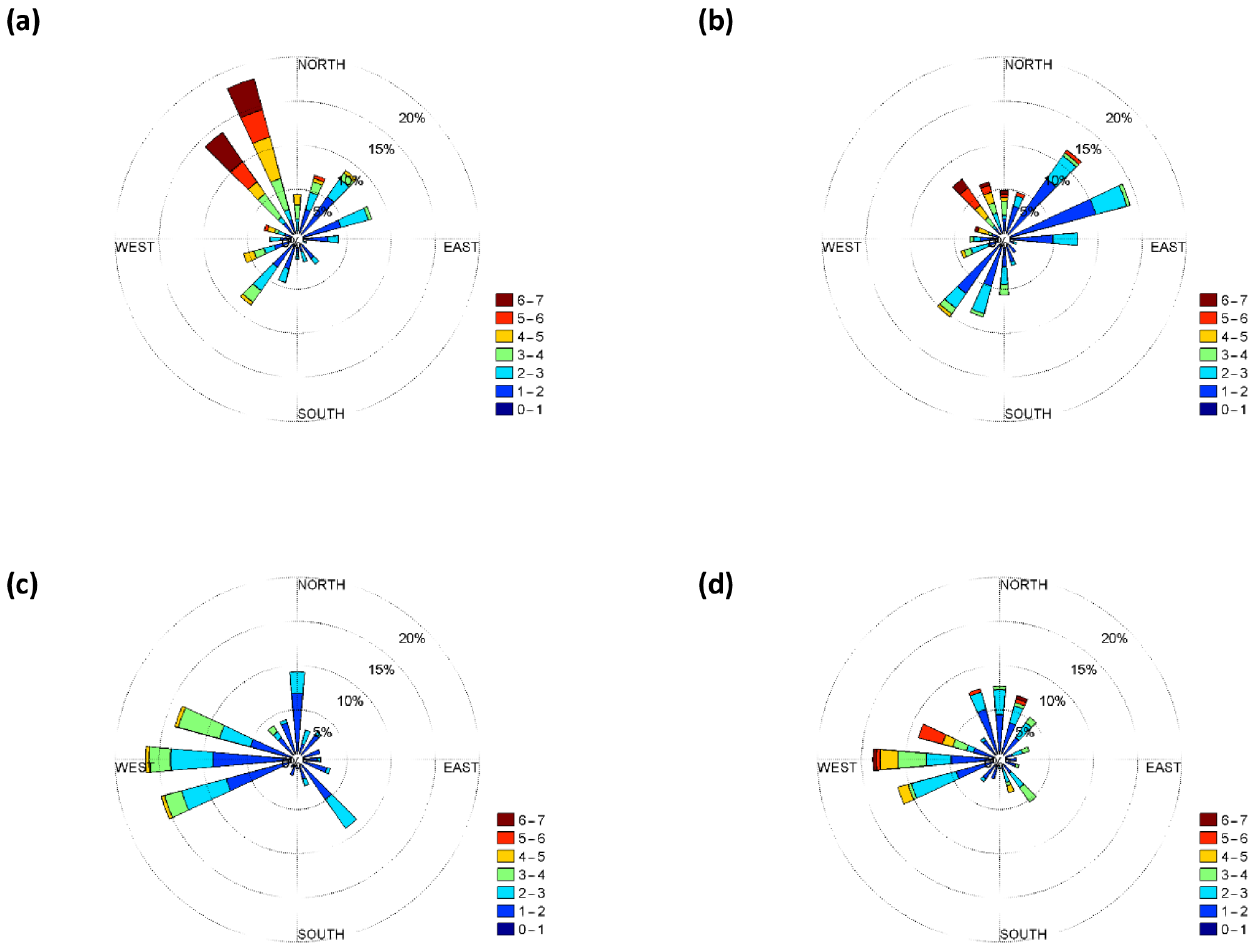
Figure 7. (a) The observed wind frequency and direction averaged in December of 2014 and 2015 in Beijing (a, b) and Shijiazhuang (c, d) respectively.